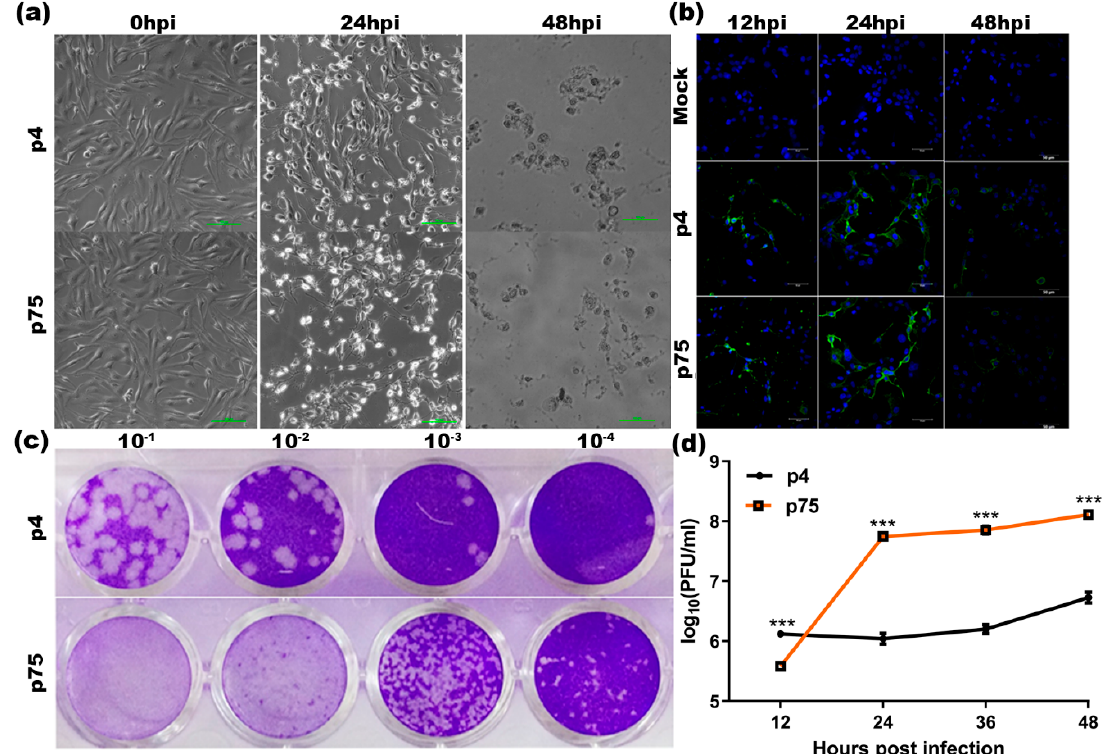
Figure 1. Comparison of infectivity phenotype of the wild-type virus (p4) and the attenuated strain virus (p75) ( a ) Bright-field microscopic images showing the cytopathic changes. U-87 MG cells were infected with either p4 or p75 at MOI 1 and incubated for different time points post-infection. The incidence of cytopathic effect was observed under a microscope. Representative images were acquired at a magnification of 10 × ; Scale bar—500 µ m ( b ) Immunofluorescence detection of p4 and p75 virus infection. Mock-infected and virus-infected U-87 MG cells at MOI 1 were incubated for 24 hpi and 48 hpi. Cells were fixed using 4% paraformaldehyde and subjected to immunofluorescence analysis. Infection was detected using an in-house anti-CHIKV E2 envelope protein rabbit polyclonal serum at 1:50 dilution and using the secondary antibody, Alexafluor 488 anti-rabbit IgG. Representative images were acquired at a magnification of 10 × ; Scale bar—500 µ m ( c ) Plaque morphology of p4 and p75 viruses. A monolayer culture of the Vero cells was grown in 24-well plate and infected with either p4 or p75 in 10-fold dilutions. The cells were overlaid with 3% carboxymethyl cellulose in 2 × DMEM with 2% FBS, after removing the un-adsorbed viruses and a PBS wash. The cells were fixed at 48 hpi and stained with 0.02% crystal violet to visualize the plaques. ( d ) Replication kinetics of p4 and p75 virus. U-87 MG cells were infected at MOI 1 and the culture supernatants were collected at different times post-infection and titrated on a confluent Vero cell monolayer by plaque assay. The number of plaques were counted to find the PFU/mL. Average number of plaques from 3 independent experiments performed in duplicate wells with countable plaques (<100) were used to plot the graph. Two-way ANOVA with Bonferroni test to compare the replicate means by row was applied. *** p value corresponds to p < 0.001 (p4 vs. p75). Data were pooled from 3 independent experiments and are presented as the means ±